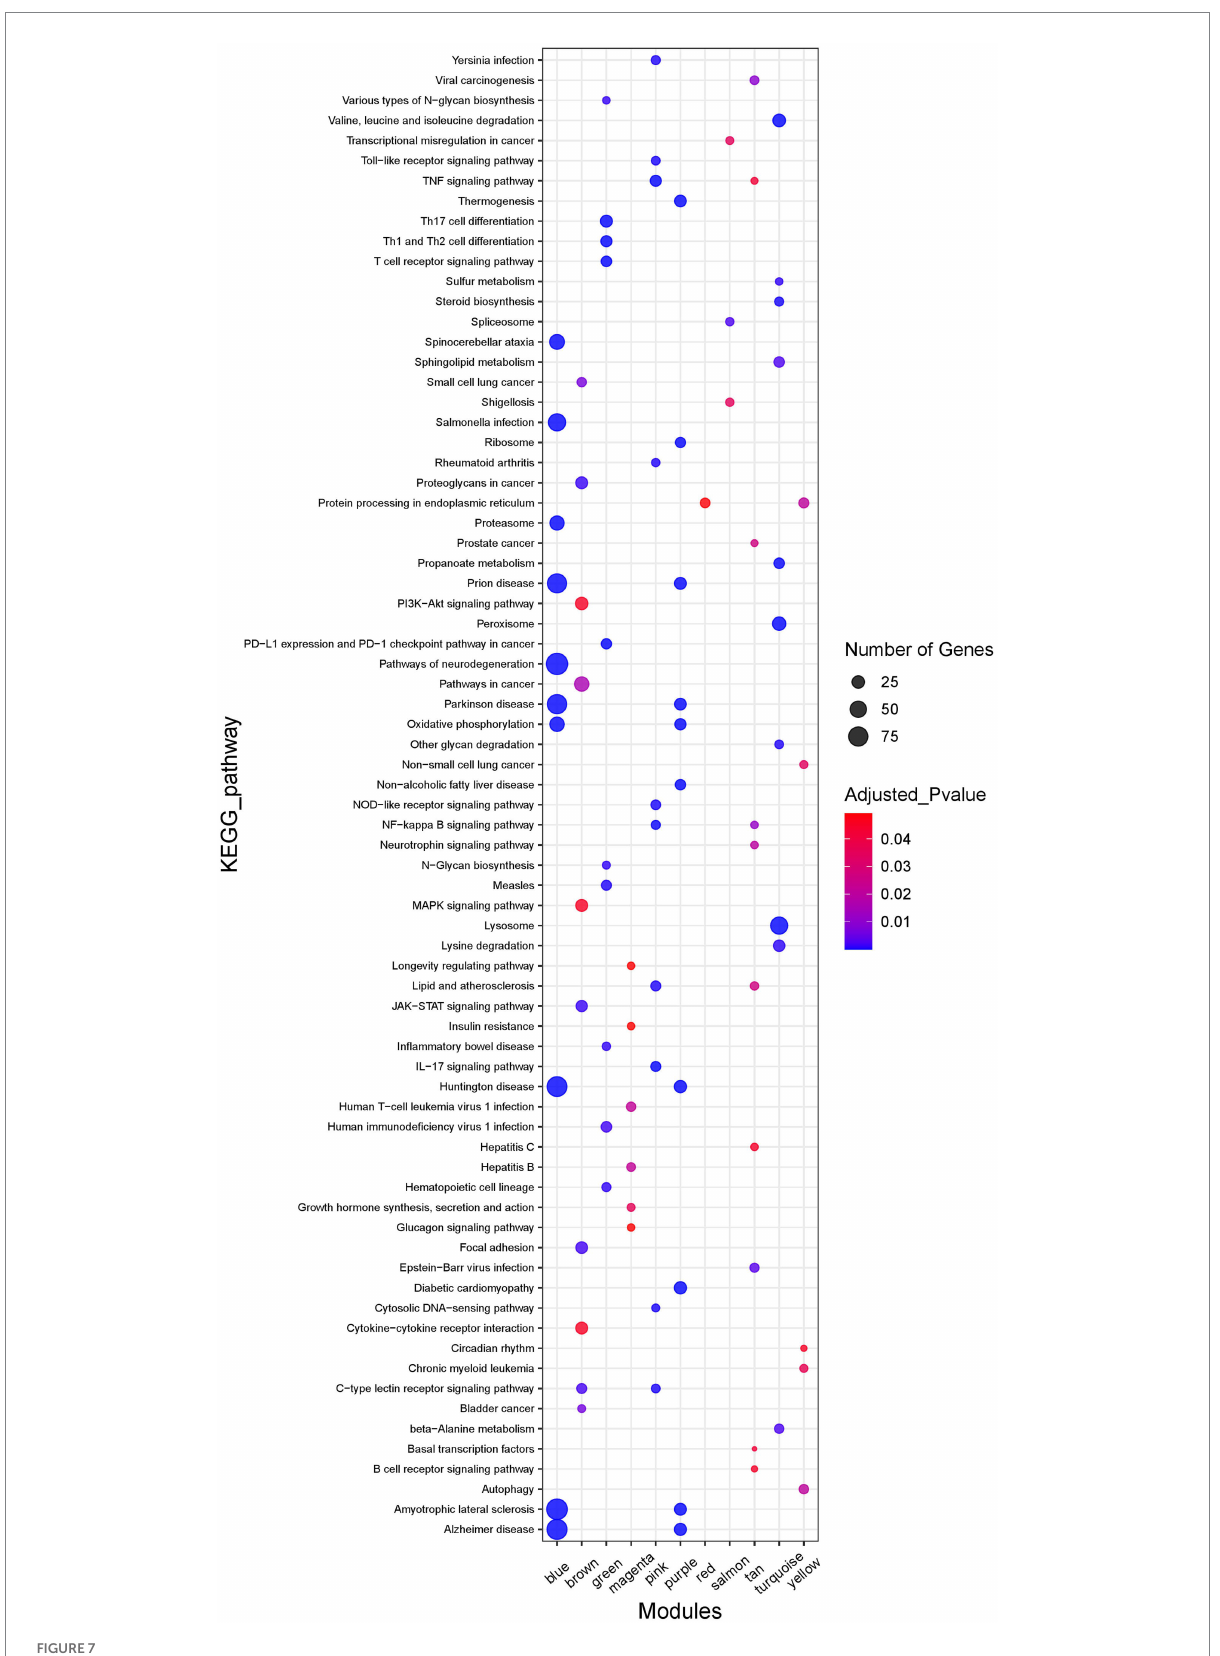
FIGURE 7 Dot plot of functional enrichment analysis. The top 10 significant KEGG pathway GO terms of the non-preserved modules. The y -axis represents significant enriched GO terms and the x -axis represents module name. Color and size of each point represent adjusted p -value and number of genes for each term,